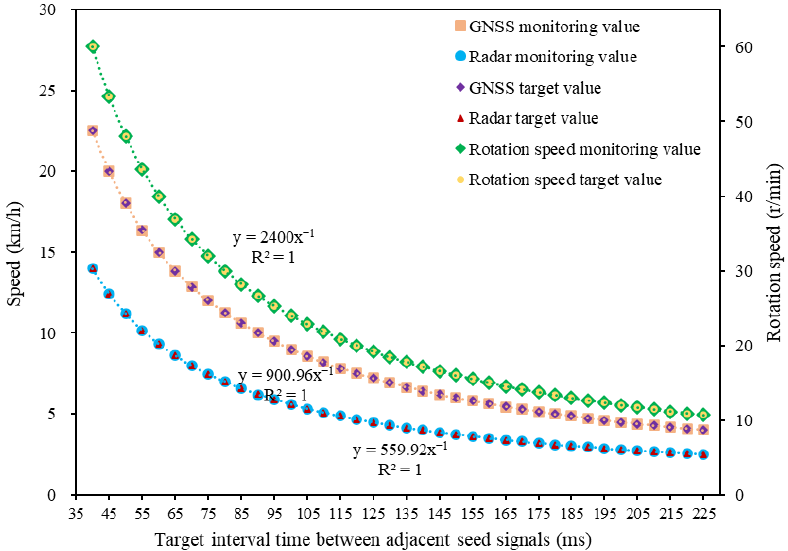
Figure 12. Simulation test monitoring results of three speed measurement methods.